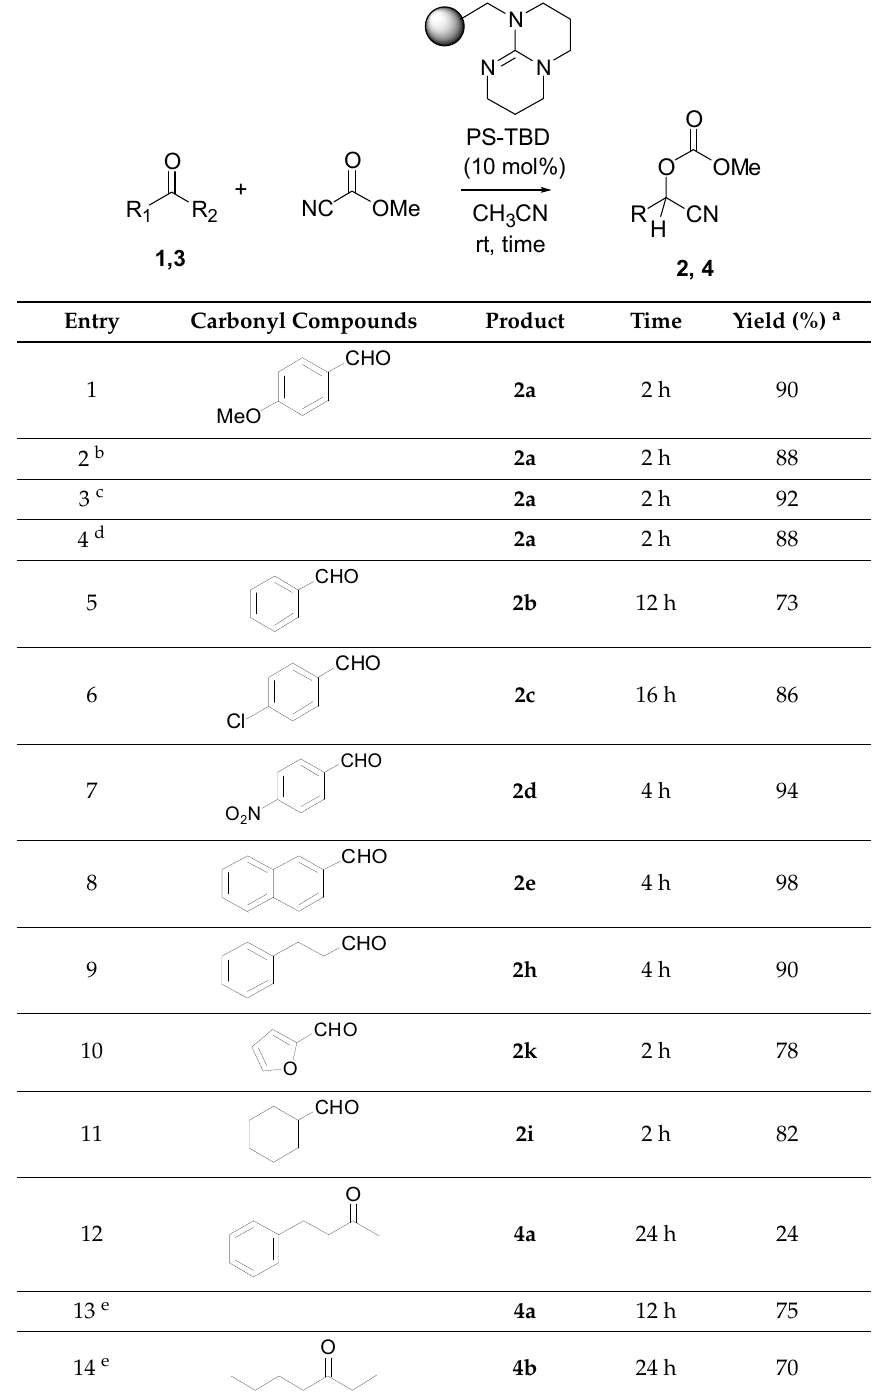
Table 4. PS (polymer-supported)-TBD catalyzed cyanation of carbonyl compounds with methyl cyanoformate.